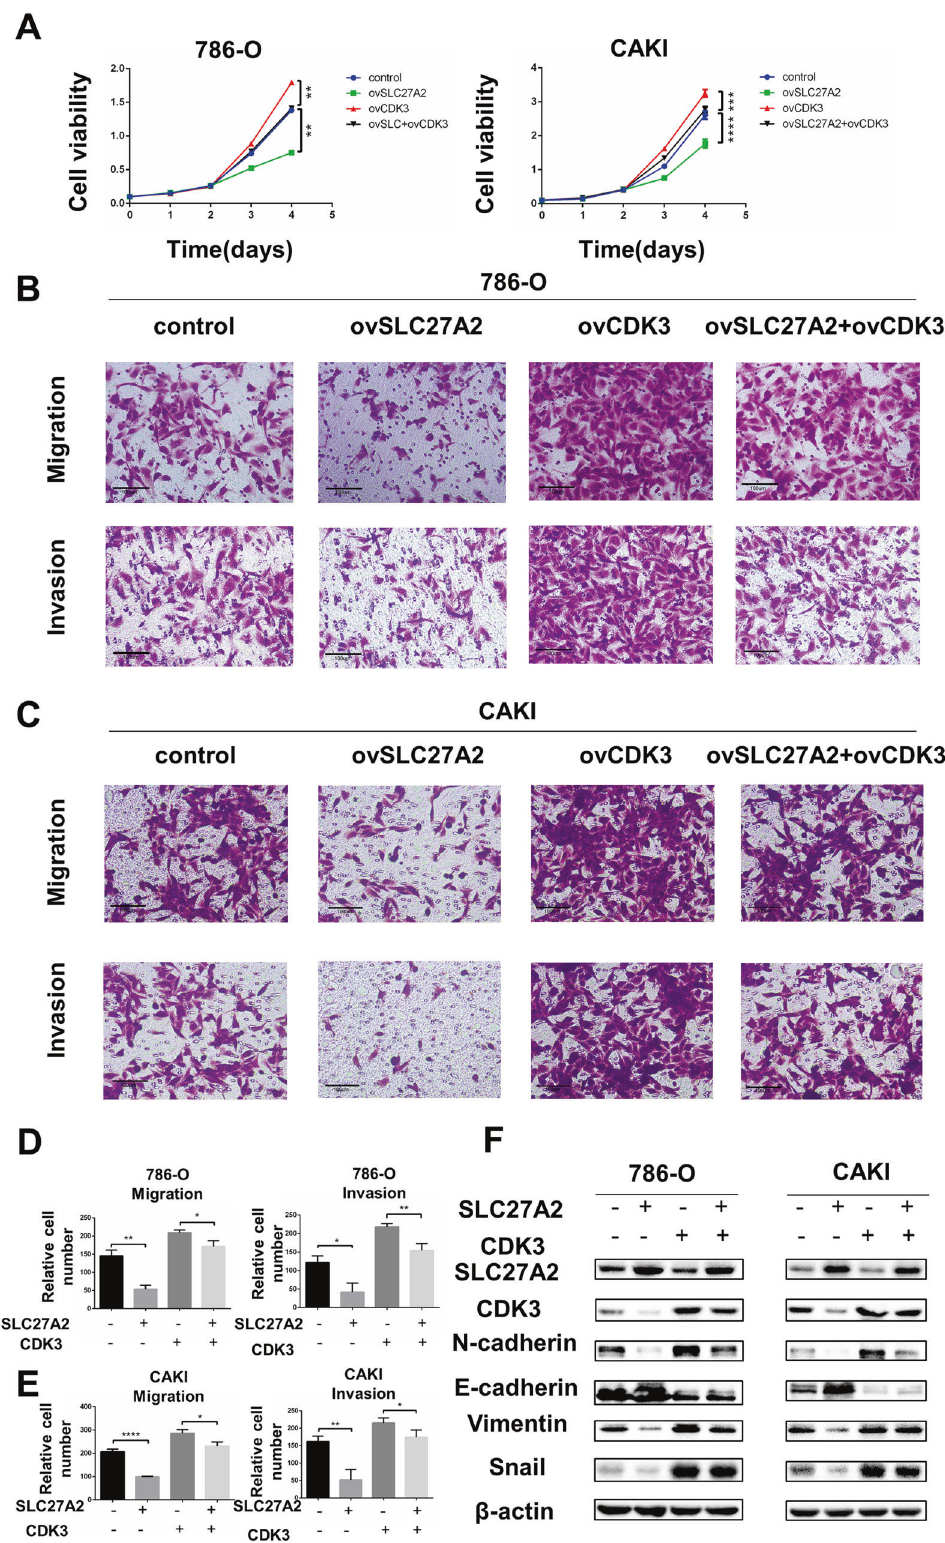
Fig. 7 SLC27A2 promoted EMT signaling and ccRCC metastasis in a CDK3-mediated manner. A Cell growth curves of CCK8 assays for indicated cells. B – E Migration and invasion assay for indicated ccRCC cells (Magni fi cation: 200×). t -test, * p < 0.05, ** p < 0.01,*** p < 0.001, **** p < 0.0001. F The expression change of EMT markers in indicated cells.